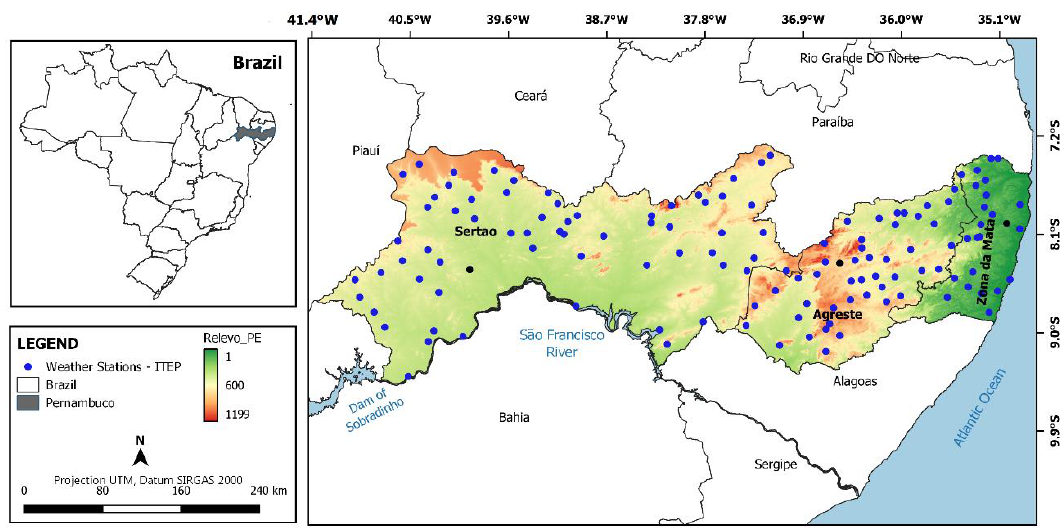
Figure 1. Geographical location of the state of Pernambuco, Brazil, and the spatial arrangement of the ITEP weather stations, with incorporated topographic information.